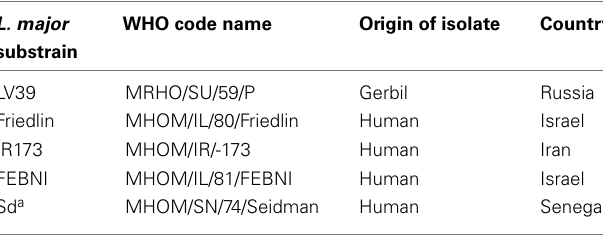
Table 1 | Origins of the L. major substrains discussed in this